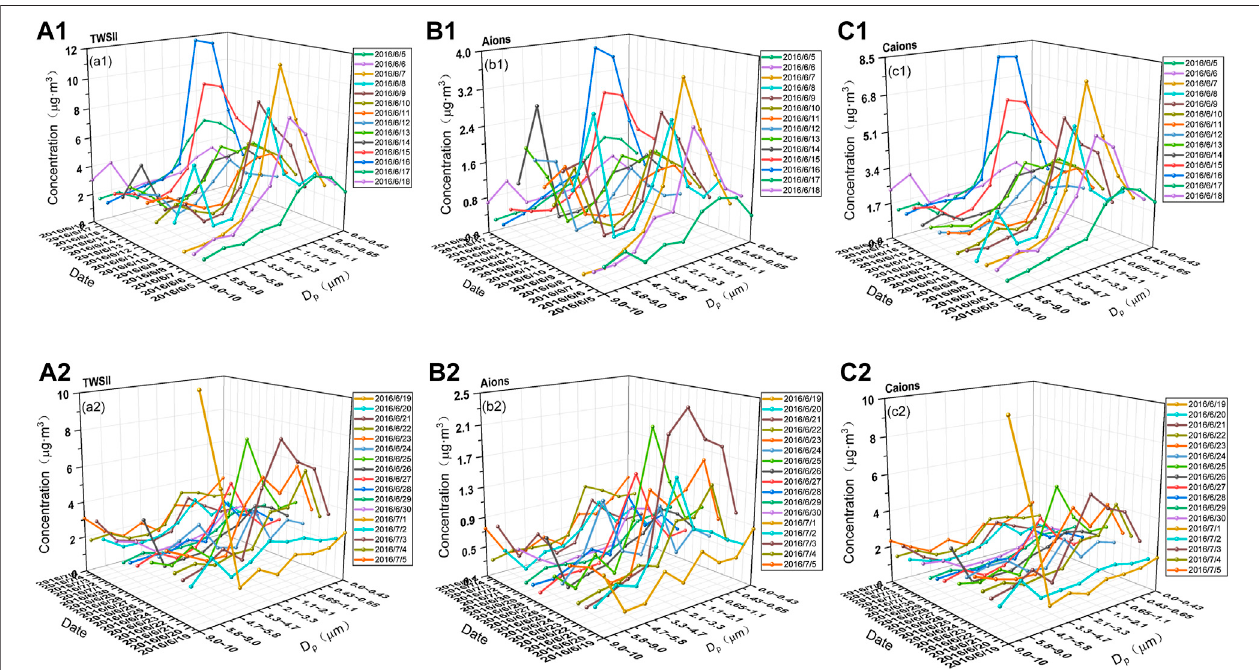
FIGURE 6 | Daily variations in spectral distribution of water-soluble inorganic (a1, a2) ionic (b1, b2) aions and (c1, c2) caions at different period ((a1, b1, c1) before the Meiyu period and (a2, b2, c2) during the Meiyu period).